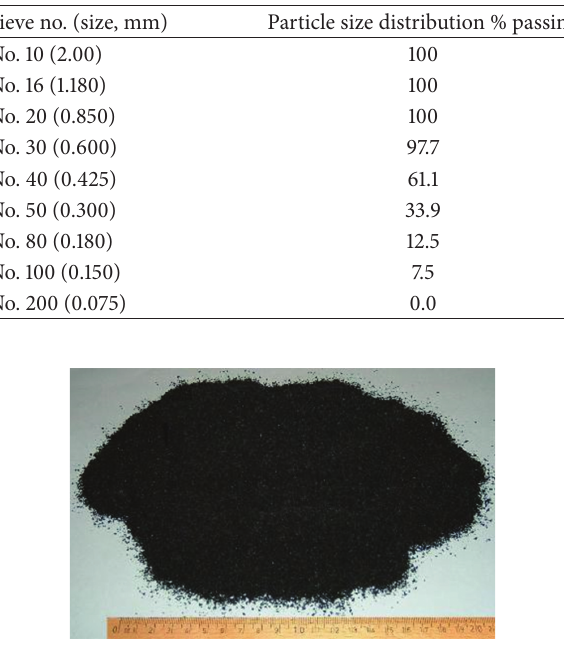
Figure 1: Crumb rubber size